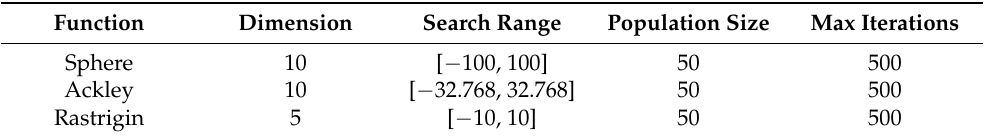
Table 1. The parameters for optimization test function.